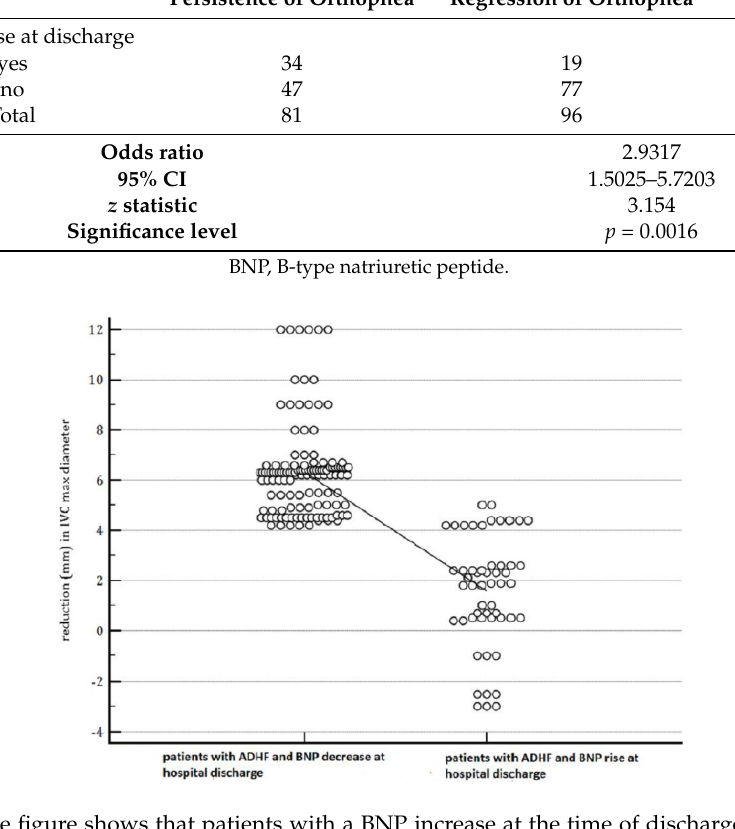
Table 3. A 2 × 2 contingency table showing that, in patients hospitalized for acute decompensated heart failure, the odds of persistent orthopnea is significantly higher among patients with a BNP increase at discharge (yes) compared with those free from this laboratory finding (no). For further explanations, please see the text.